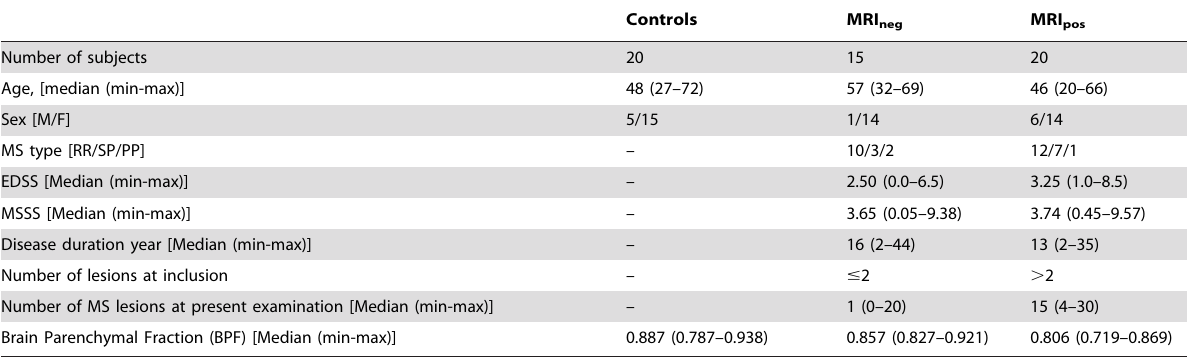
Table 1. Subjects.